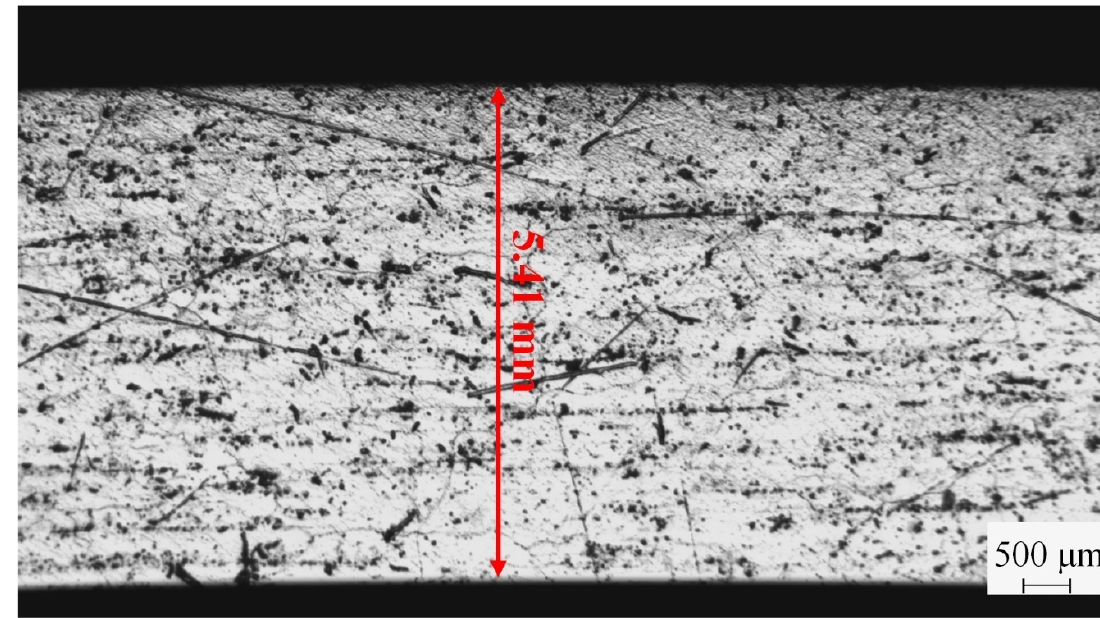
Figure 5. Workpiece thickness measured by experiment.